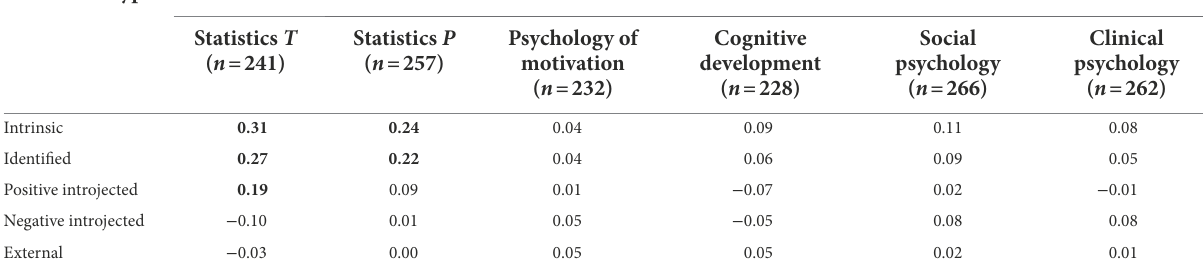
TABLE 8 Correlations between motivation types and grades in corresponding